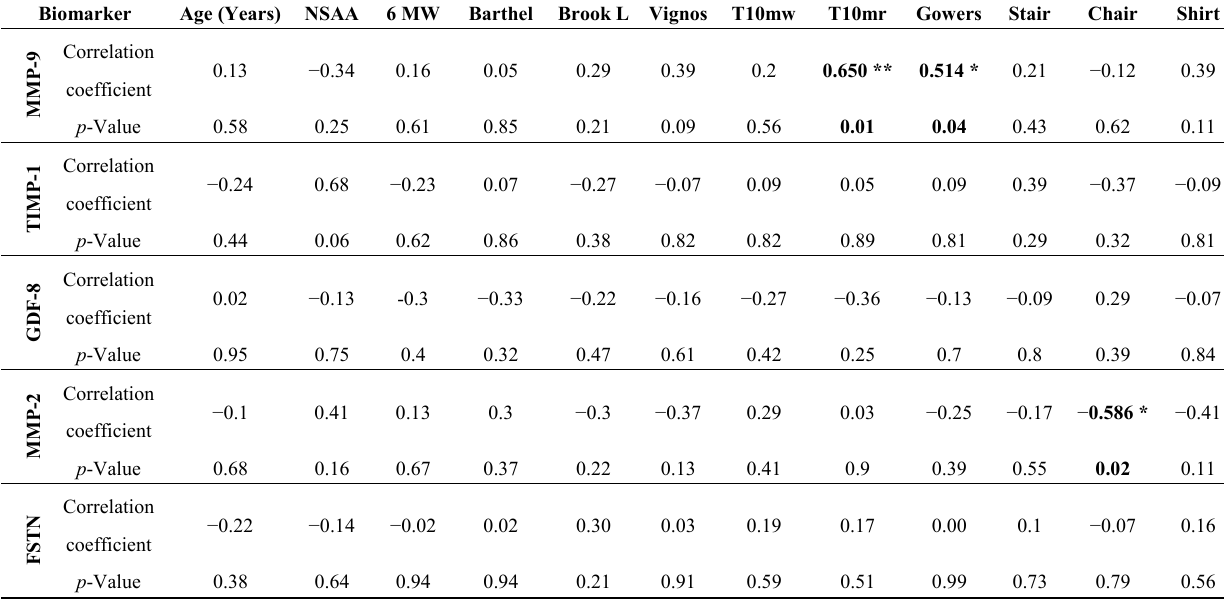
Table 2. Correlation between levels of biomarkers and clinical parameters of steroid naïve DMD ambulant patients. ** Correlation is significant at the 0.01 level (two-tailed). * Correlation is significant at the 0.05 level